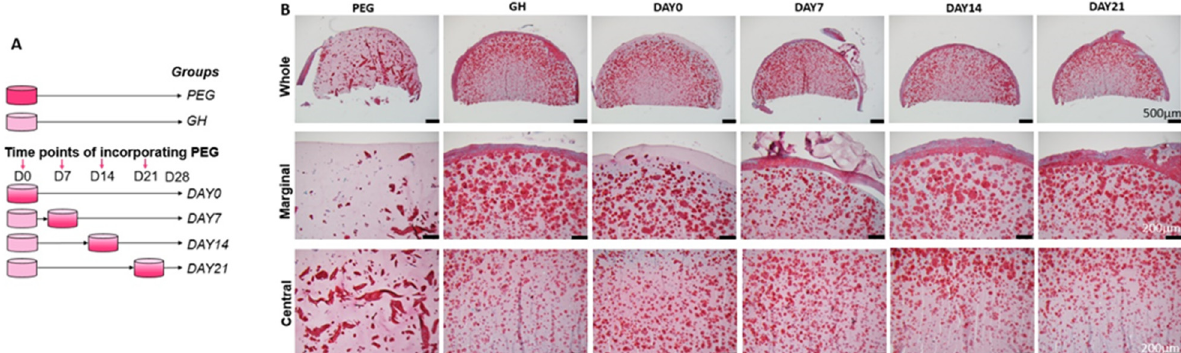
Figure 2. ( A ). Schematic showing the group information. At different points during 28 days of chondrogensis, PEG was incorporated into GH scaffold. ( B ). Safranin O staining to assess GAG deposition in different groups. DAY0, 7, 14, 21 indicated that PEG was introduced at Day 0, 7, 14, 21 of chondrogenic culture. Bar = 500 µ m in the top panel and 200 µ m in the middle and bottom